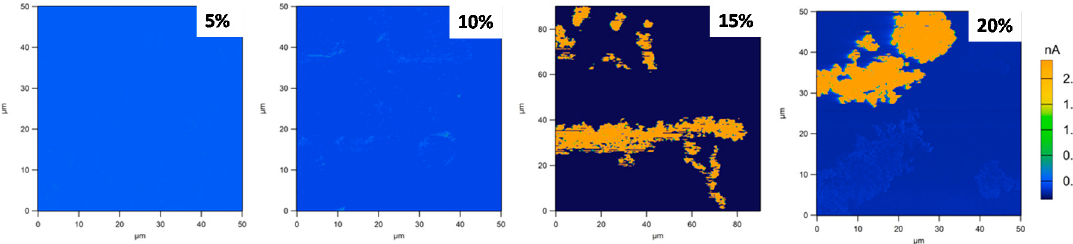
Figure 7. The conductive atomic force microscopy (C-AFM) current images of the Al 2 O 3 –TiN-10 composites with 5, 10, 15 and 20 vol % TiN, respectively. The colour contours indicate the current of the areas.